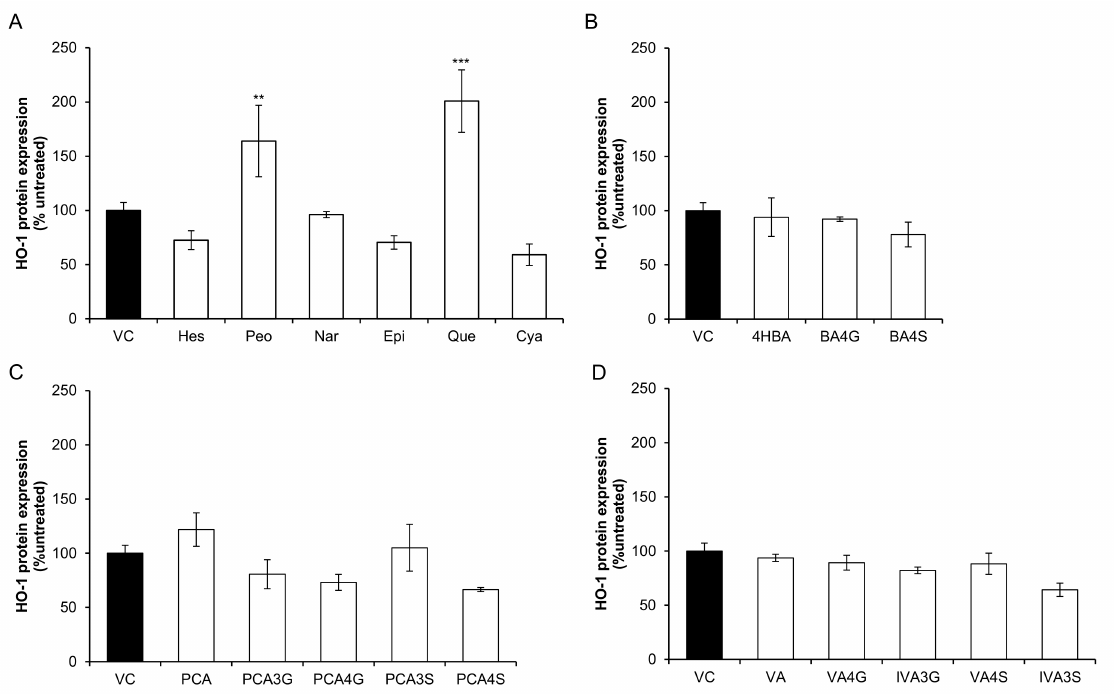
Figure 2. Effect of 10 µ M flavonoids and phenolic acid metabolites on HO-1 protein expression in RASMCs. ( A ) precursor flavonoids; ( B ) benzoic acid metabolites; ( C ) protocatechuic acid metabolites; and ( D ) vanillic acid metabolites. Data are presented as a percentage of an untreated control (media only). Filled columns represent vehicle control (0.02% DMSO) and clear columns represent treatments (10 µ M). All columns are representative of the mean ± SD, n = 3 independent samples, ** p ≤ 0.01, *** p ≤ 0.001 (ANOVA with post hoc Dunnett relative to vehicle control (0.02% DMSO)).